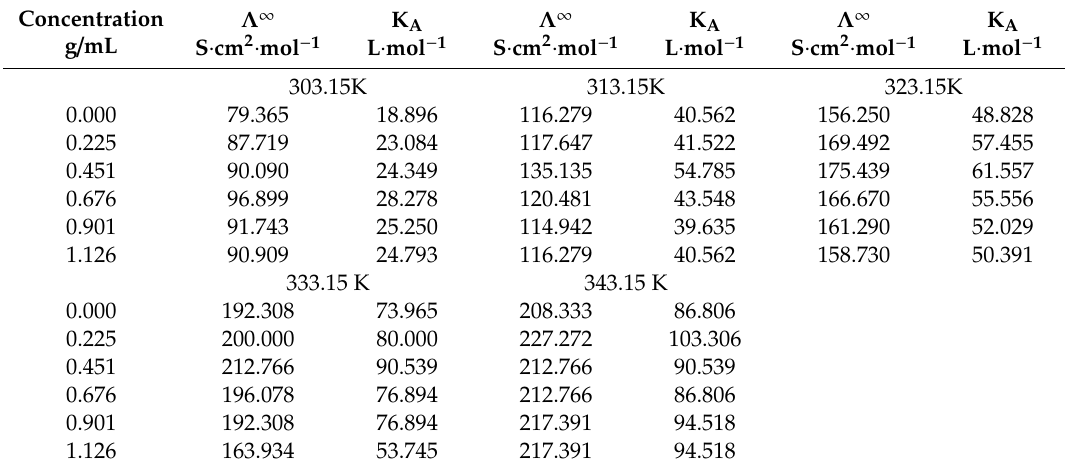
Table 3. Limiting molar conductivities and association constants of [C 3 Tr][PF 6 ]-alkaloid at di ff erent concentrations and